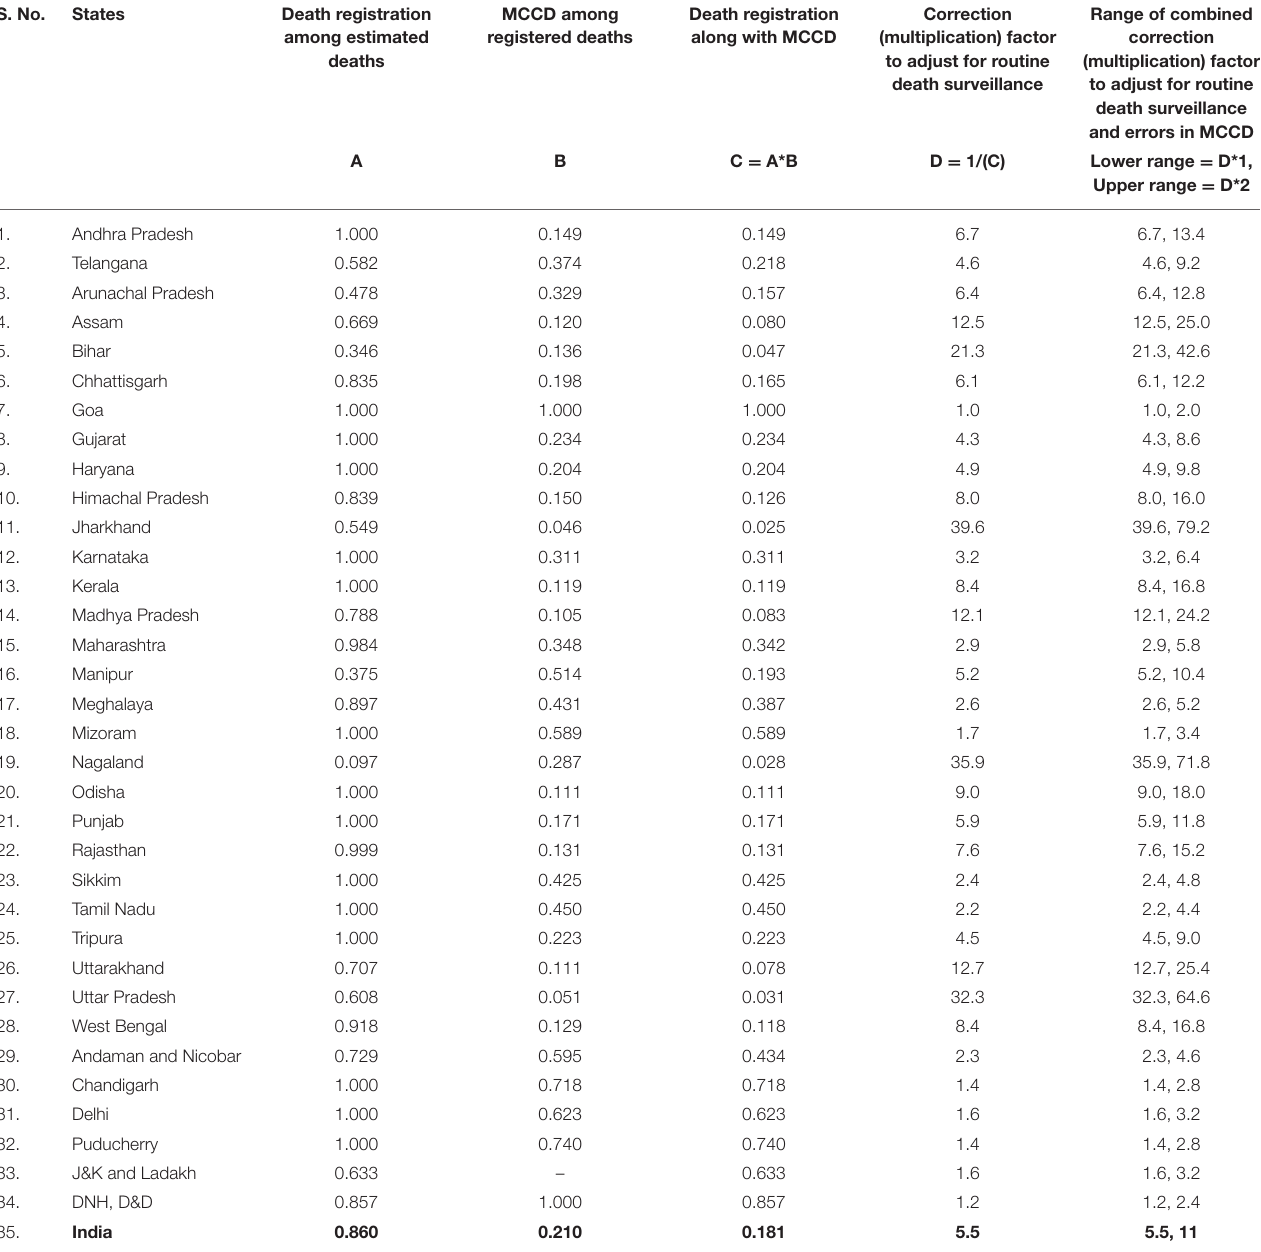
TABLE 1 | The State-wise prevailing coverage of routine death surveillance (death registration along with MCCD) and the correction factor, India (2018) (11, 12). S.